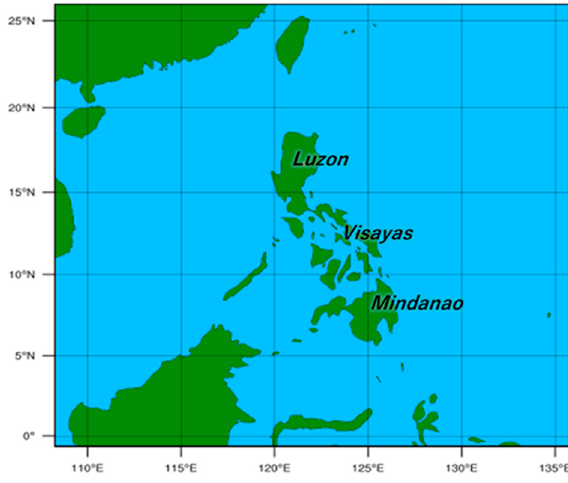
Figure 1. Simulation domains for the one-year wind simulations.